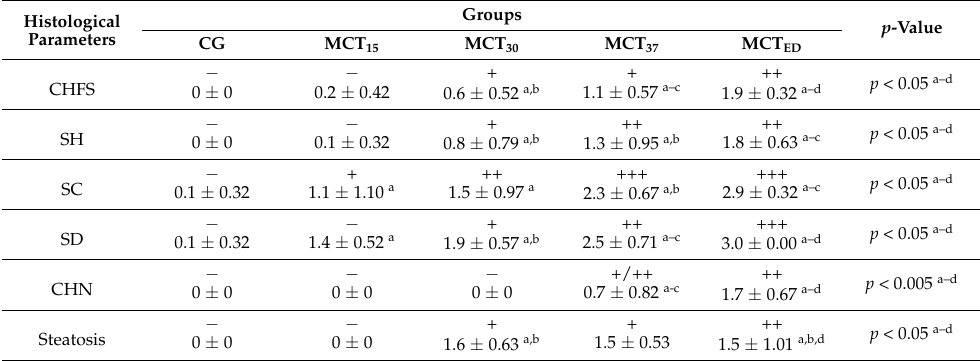
Table 1. Semiquantitative evaluation of histological parameters for the assessment of congestive